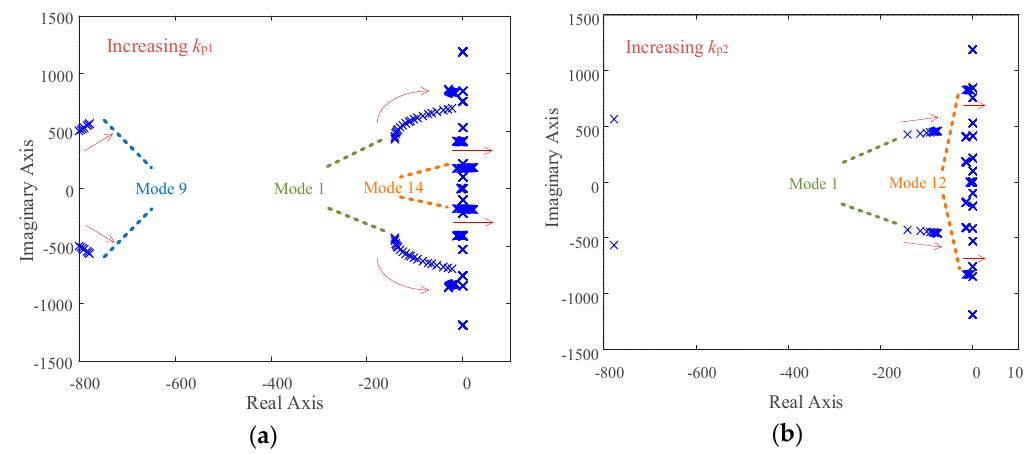
Figure 7. Eigenvalue loci ( a ) when k p 1 is increasing. ( b ) When k p 2 is increasing.